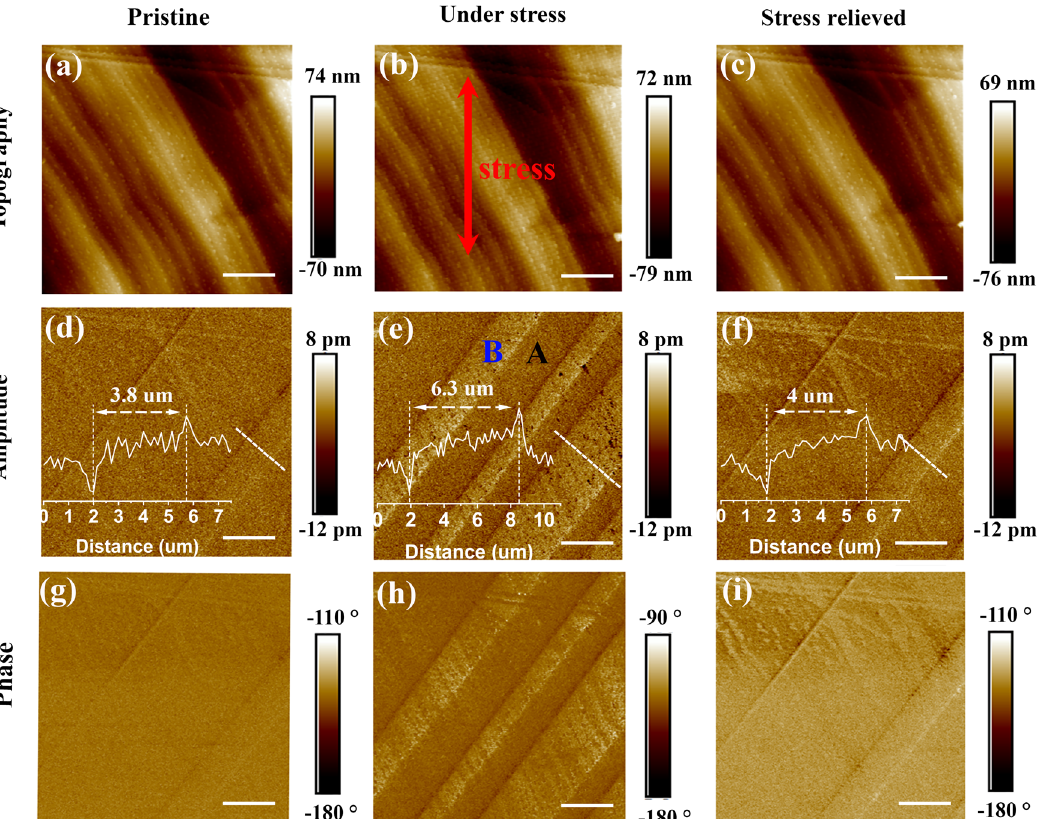
Fig. 5 External stress modulation of ferroelastic domain patterns (A and B) observed by PFM. Surface topography, PFM amplitude and phase images of TSFC at a , d , g pristine state, b , e , h under applying external stress, and c , f , i after removing the stress. The overlay plots in d , e , f are edge-to-edge topographical analyses of the dashed lines. The red arrow in b represents the direction of the applied external stress. Scale bar: 6 μ